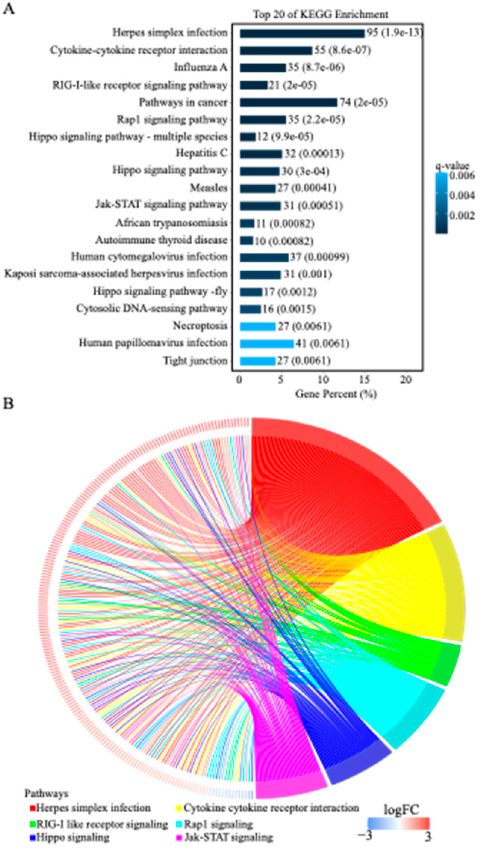
Figure 3. Significant KEGG pathways enriched by the DEGs. ( A ) Top 20 significant KEGG pathways enriched by the DEGs. The x-axis represents the proportion of annotated genes of pathways to all annotated DEGs (total 632 genes). ( B ) Chord plot of selected six signaling pathways. Scale bar represents the log2FC values of DEGs on the left half of the outer circle.